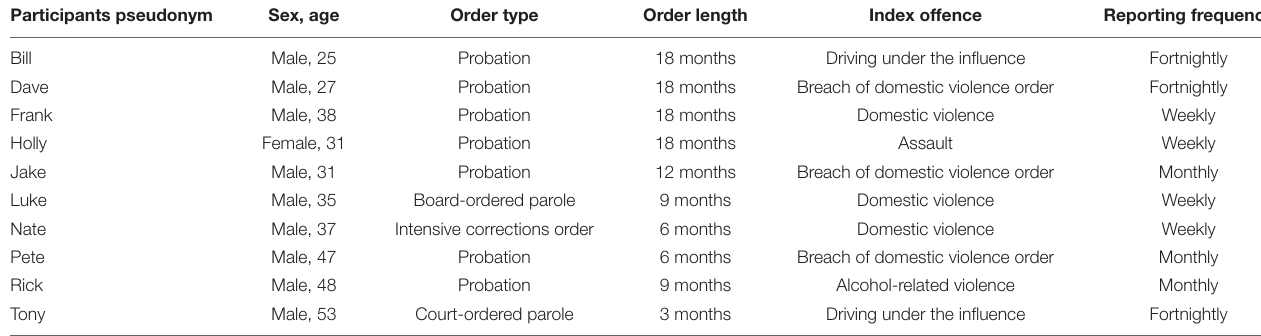
TABLE 2 | Interview participant